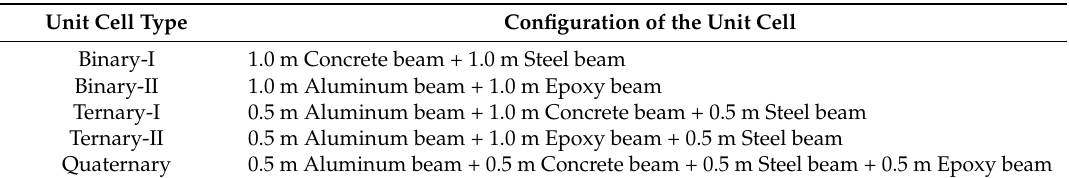
Table 1. The configuration of five kinds of unit cell in our exemplified bi-coupled periodic beams.